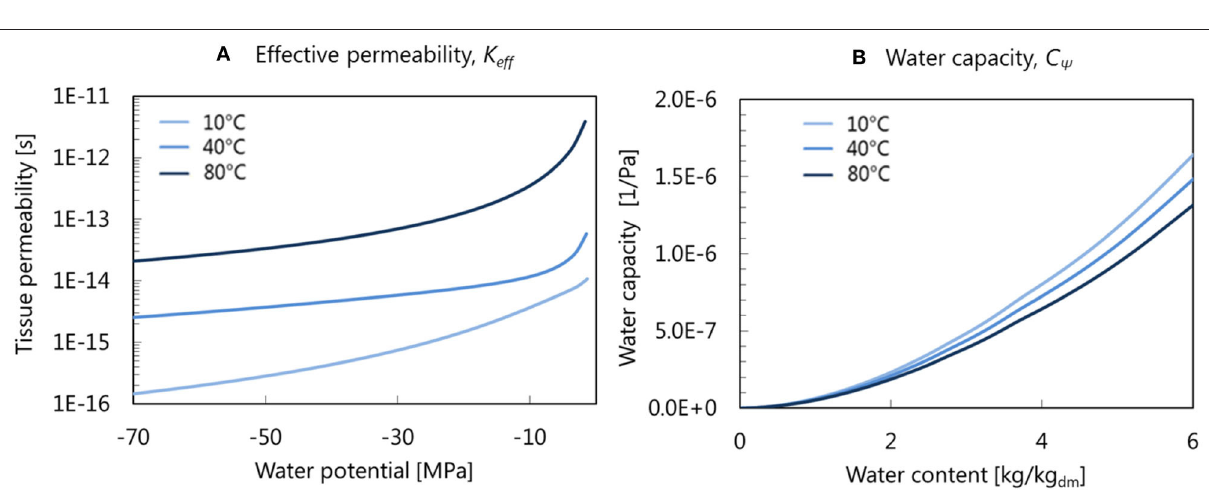
FIGURE 1 | Solar dryer configuration used in the modeling: (A) the basic configuration, (B) solar collector with thermal storage made of sand bed, (C) solar dryer equipped with a dehumidifier unit consisting of silica gel, and (D) solar dryer equipped with an auxiliary heating unit (air heater). The basic configuration is based on the solar dryer developed by Reyes et al. (2013) and Vásquez et al. (2019).